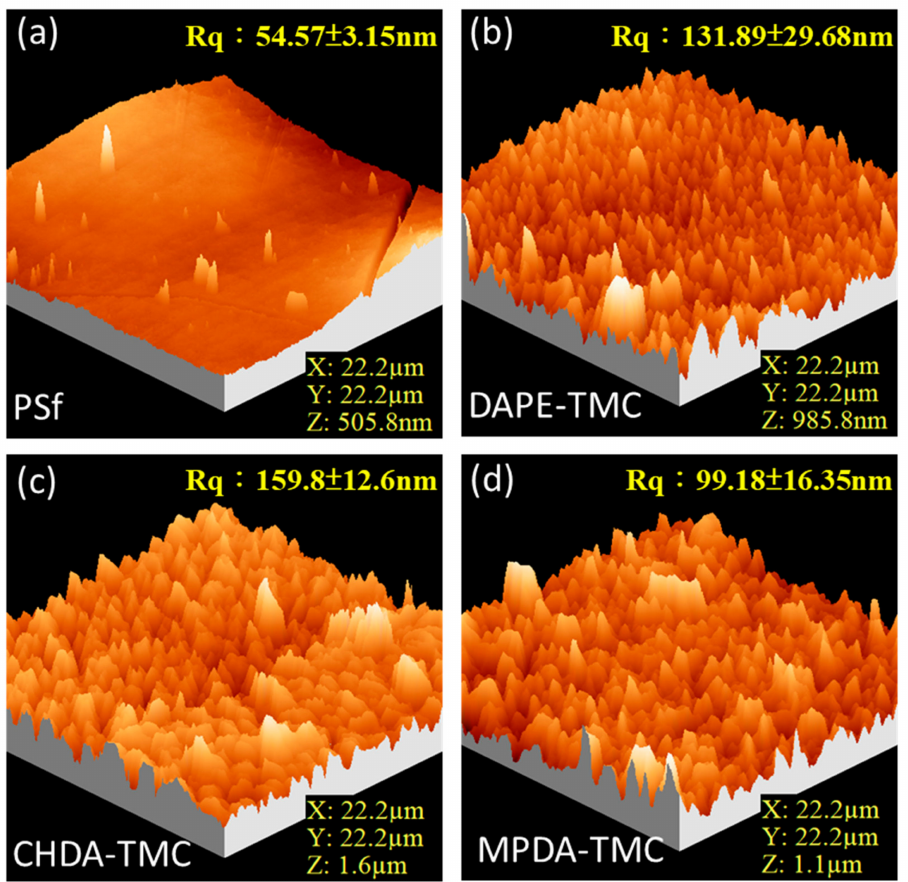
Figure 6. Three-dimensional AFM images: ( a ) PSf support; ( b ) DAPE-TMC; ( c ) CHDA-TMC; ( d )